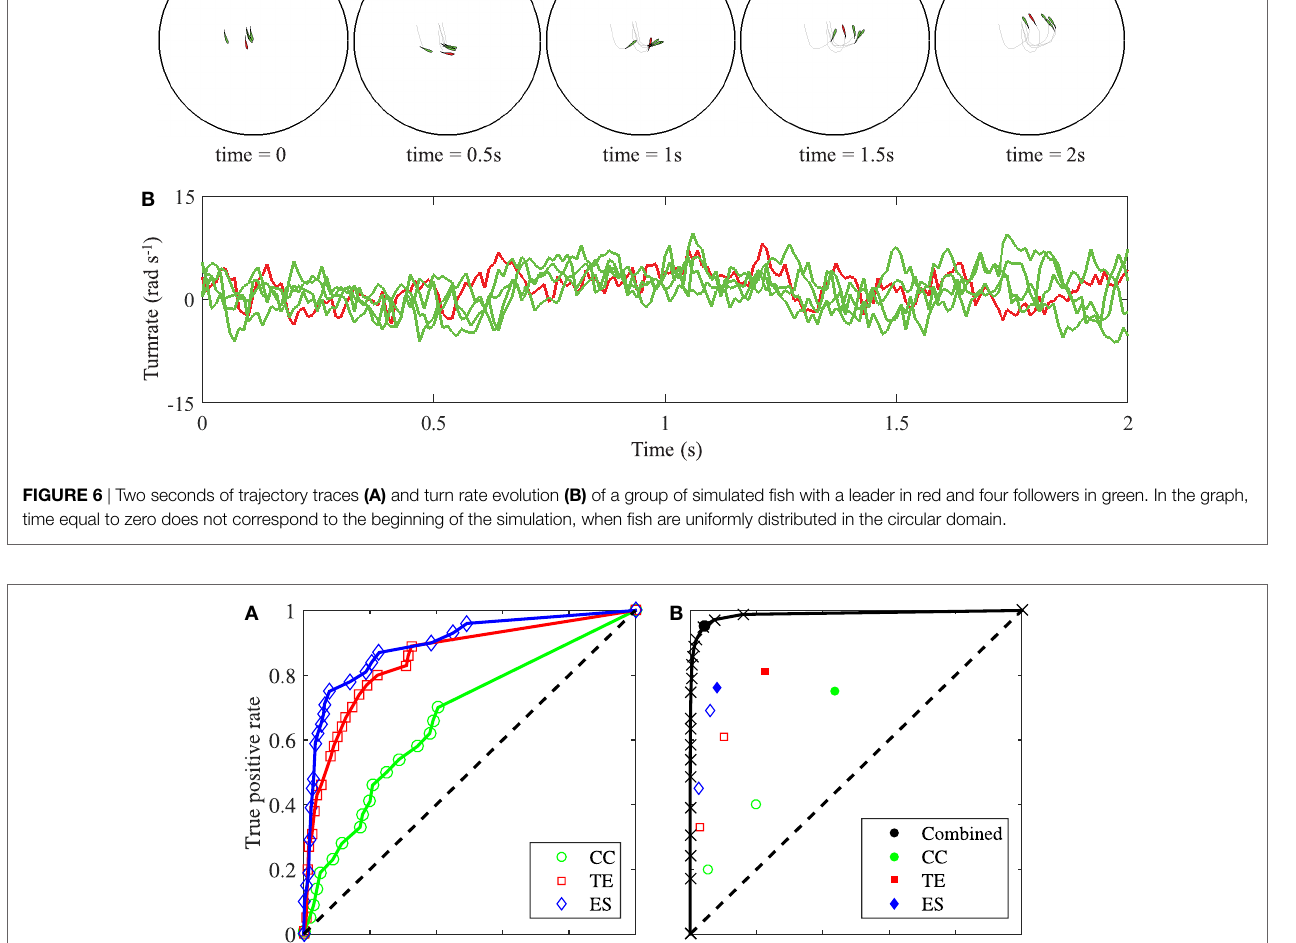
FIGURE 7 | ROC curve for the data-driven model of fish behavior with a single leader generated using each of the three classification methods (A) and a combined approach (B) , which integrates the ROCs from the three methods plotted using only 20 sampled points over a total of 512. The combined ROC is obtained by sampling three points on the ROC for each method. In panel (A) , the AUC for CC, TE, and ES is estimated at 0.67, 0.85, and 0.90, respectively. In panel (B) , the selected cutoff points are chosen such that the first point is just above the 25% quartile, the second is just above the 50% quartile, and the third one is the operating point. The operating point for each individual method is identified as a solid marker, and the other two as open markers. The operating point of the combination of the three classifiers is shown as a solid marker and has ROC coordinates (0.04, 0.95). The AUC from the combined method is 0.99.